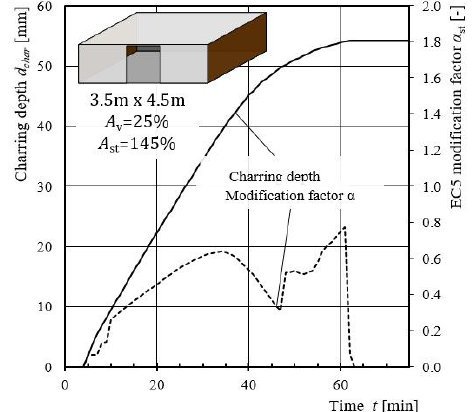
Figure 22: Predicted charring depth and modification factor α for considering the charring behaviour as function of time for the experiment V.